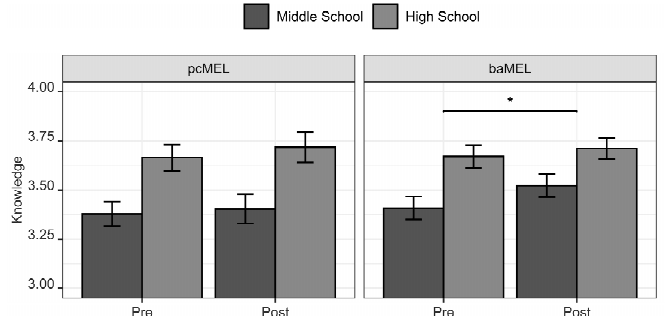
Figure 6. Knowledge scores (range 1 (strongly disagree with scientific)–5 (strongly agree with scientific)) for each instructional treatment. Errors bars indicated ± 1 standard error. Asterisk indicates a statistically significant di ff erence between pre- and post-instruction for middle school students completing the Freshwater baMEL, * p < 0.05.